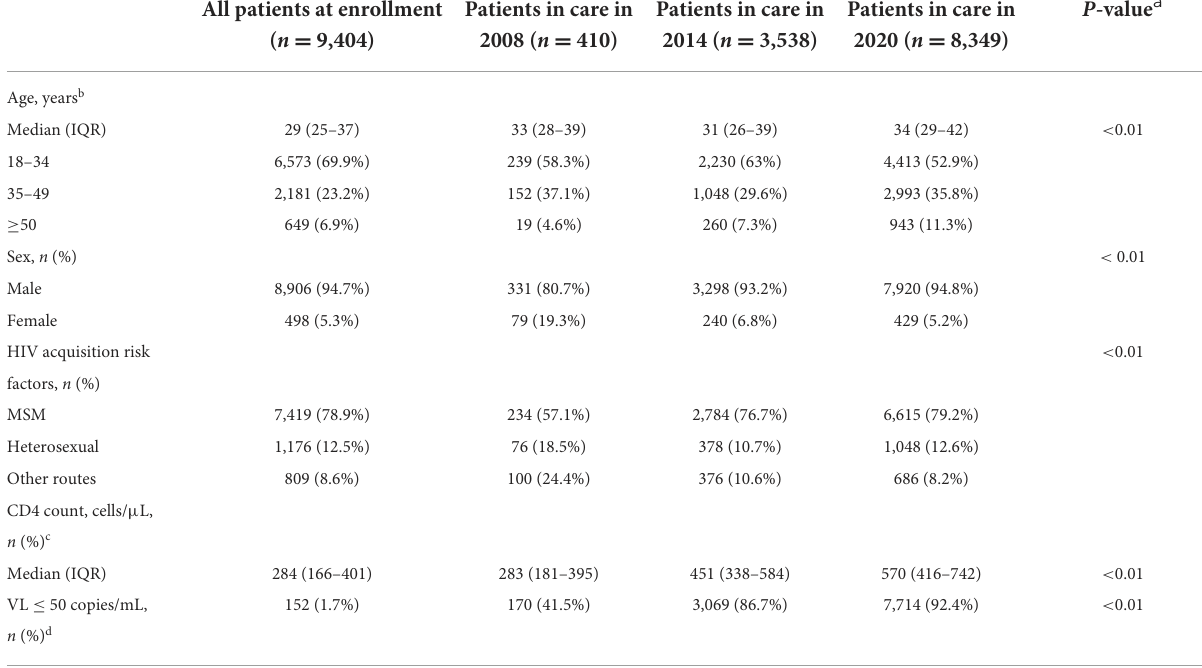
TABLE 1 Characteristics of HIV-infected patients at enrollment and across calendar years.